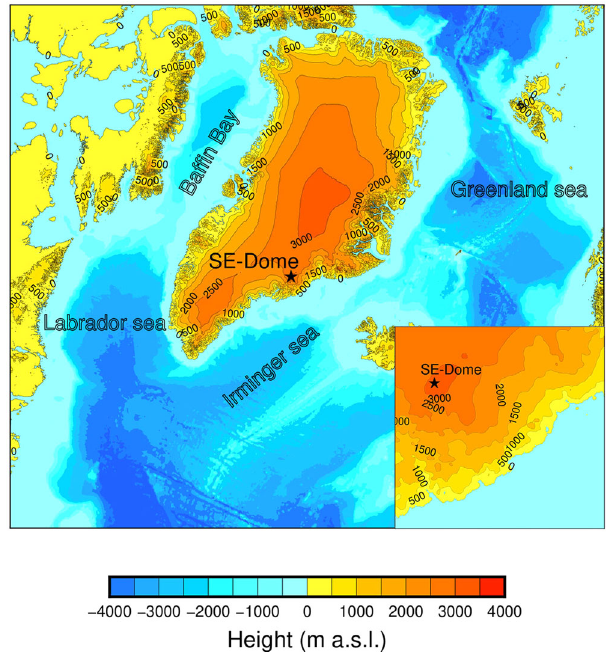
Fig. 1 SE-Dome site. The black star shows the location of the SE-Dome site. The color shade denotes topography provided by ETOPO1, which is a 1 arc- minute global relief model of Earth ’ s surface that integrates land topography and ocean bathymetry. The height of Greenland denotes the top of the Ice